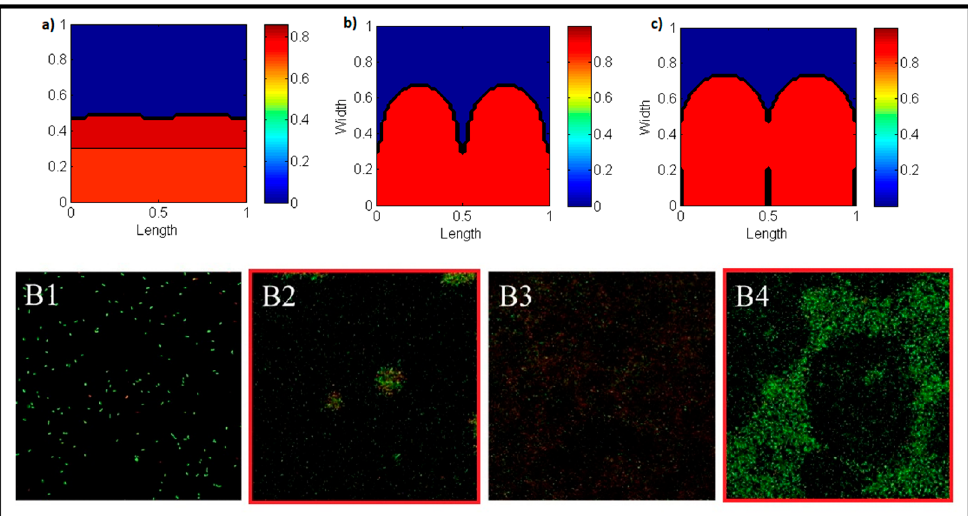
Figure 2. Numerical results for the active biomass in the 2D case. Above: ( a ) flat biofilms; ( b ) clusterd biofilms, ( c ) Honeycomb pattern. Below: CECT 5873 dynamics with IMARIS. Starting with an initial attachment (B1), the biofilm develops a clustered structure (B2). After the apparition of an important quantity of inert biomass (B3), the biofilm develops a honeycomb structure. Source: